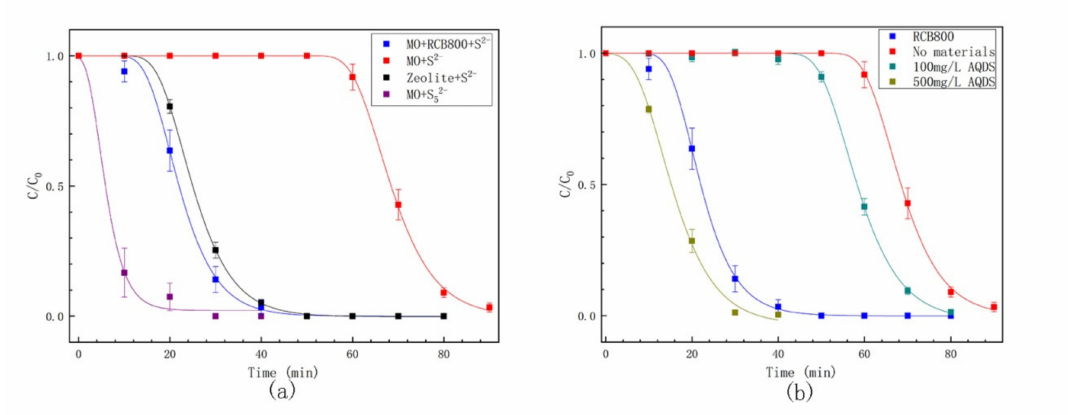
Figure 6. ( a ) Degradation of MO (0.5 mM) by sulfide (6 mM) with 100 mg/L RCB800, 500 mg/L zeolite, and no materials; degradation of MO (0.5 mM) by polysulfides (6 mM, calculated by sulfide). ( b ) Degradation of MO (0.5 mM) by sulfide (6 mM) with RCB800, 100 mg/L AQDS, 500 mg/L AQDS, and no materials. pH = 7.4, and the temperature was 30 ◦